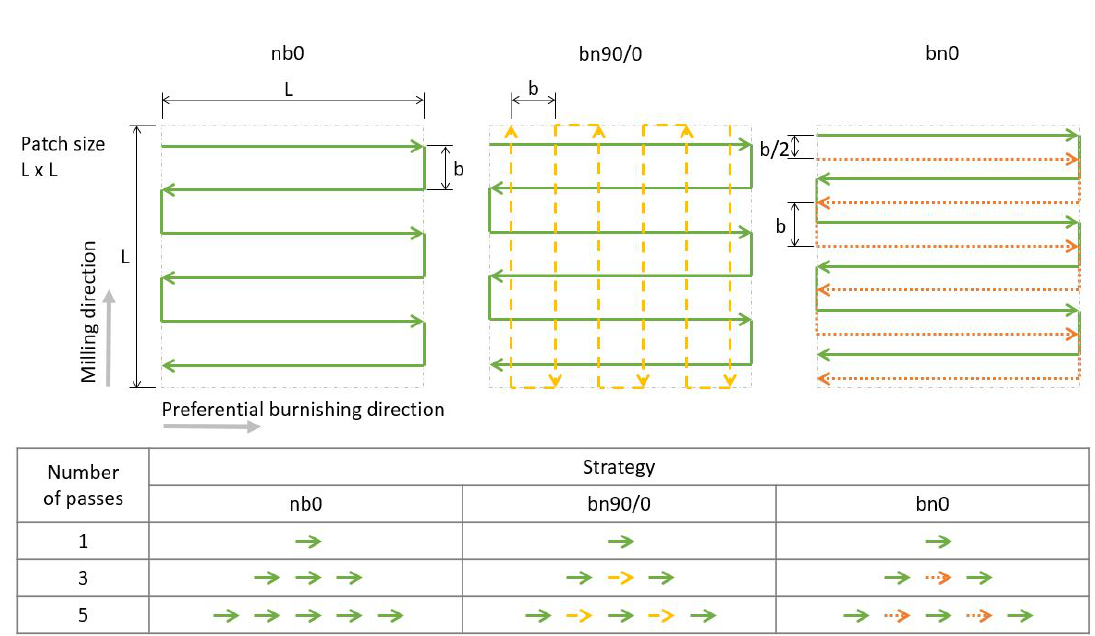
Figure 2. Representation of the path followed for each strategy depending on the number of